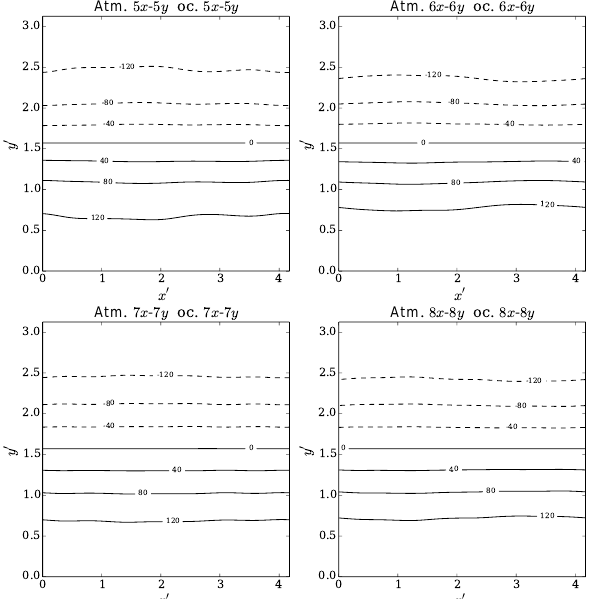
Figure 10. Climatologies for the geopotential height field z = f 0 (m) (continued from Fig. 9).